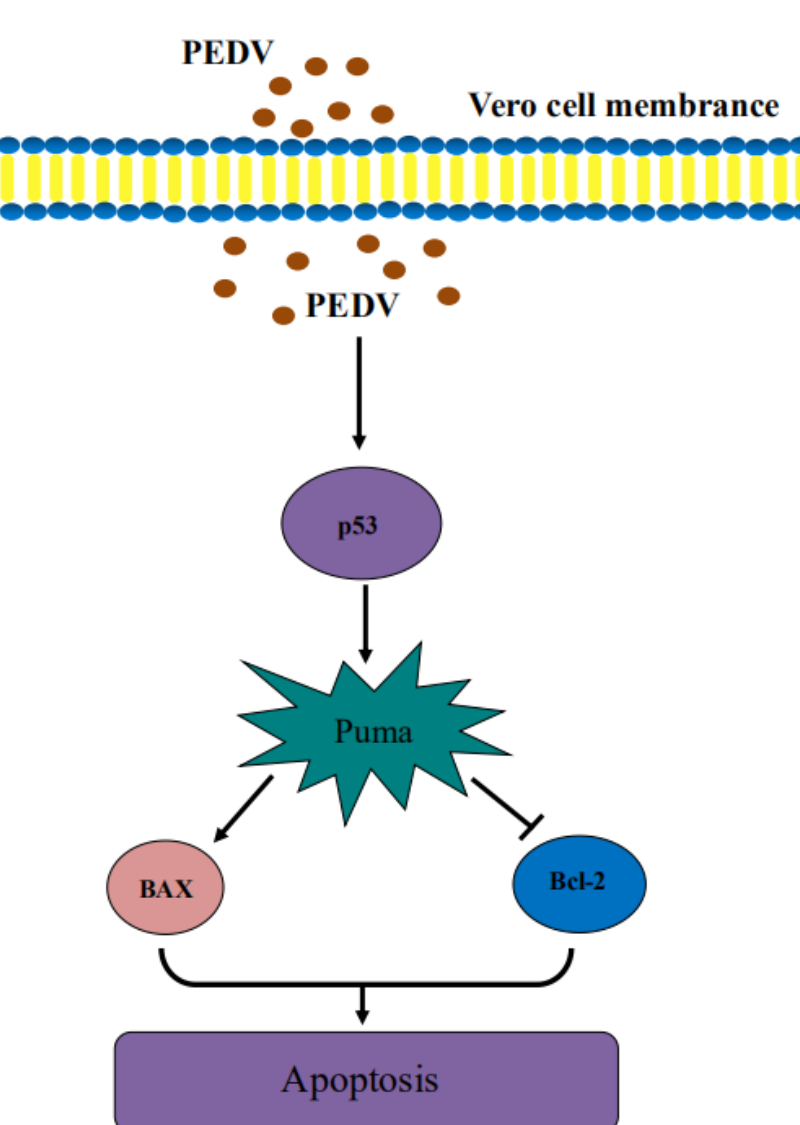
Figure 10. Schematic diagram of PEDV activating Puma and inducing apoptosis in a p53-dependent pathway.